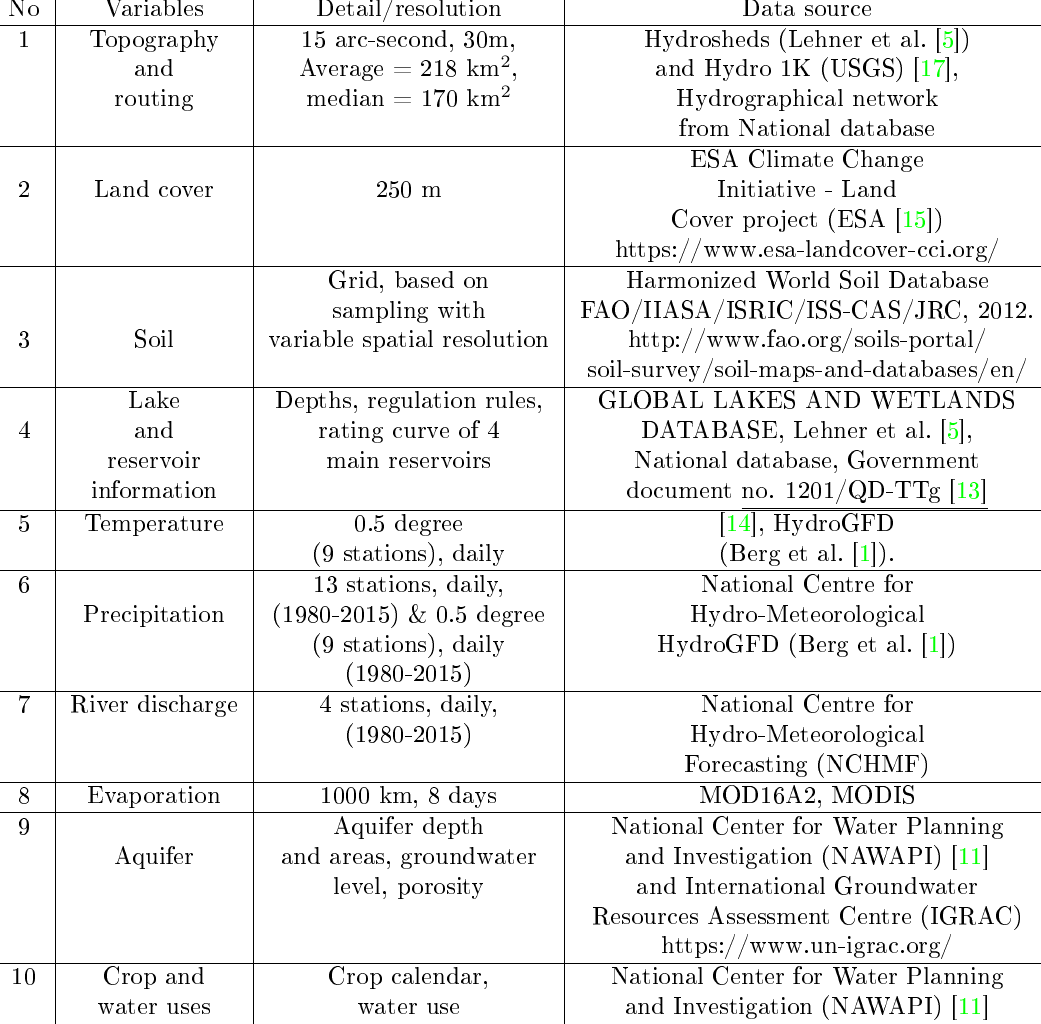
Table 1. Summary of input data of HYPE model for Serepok